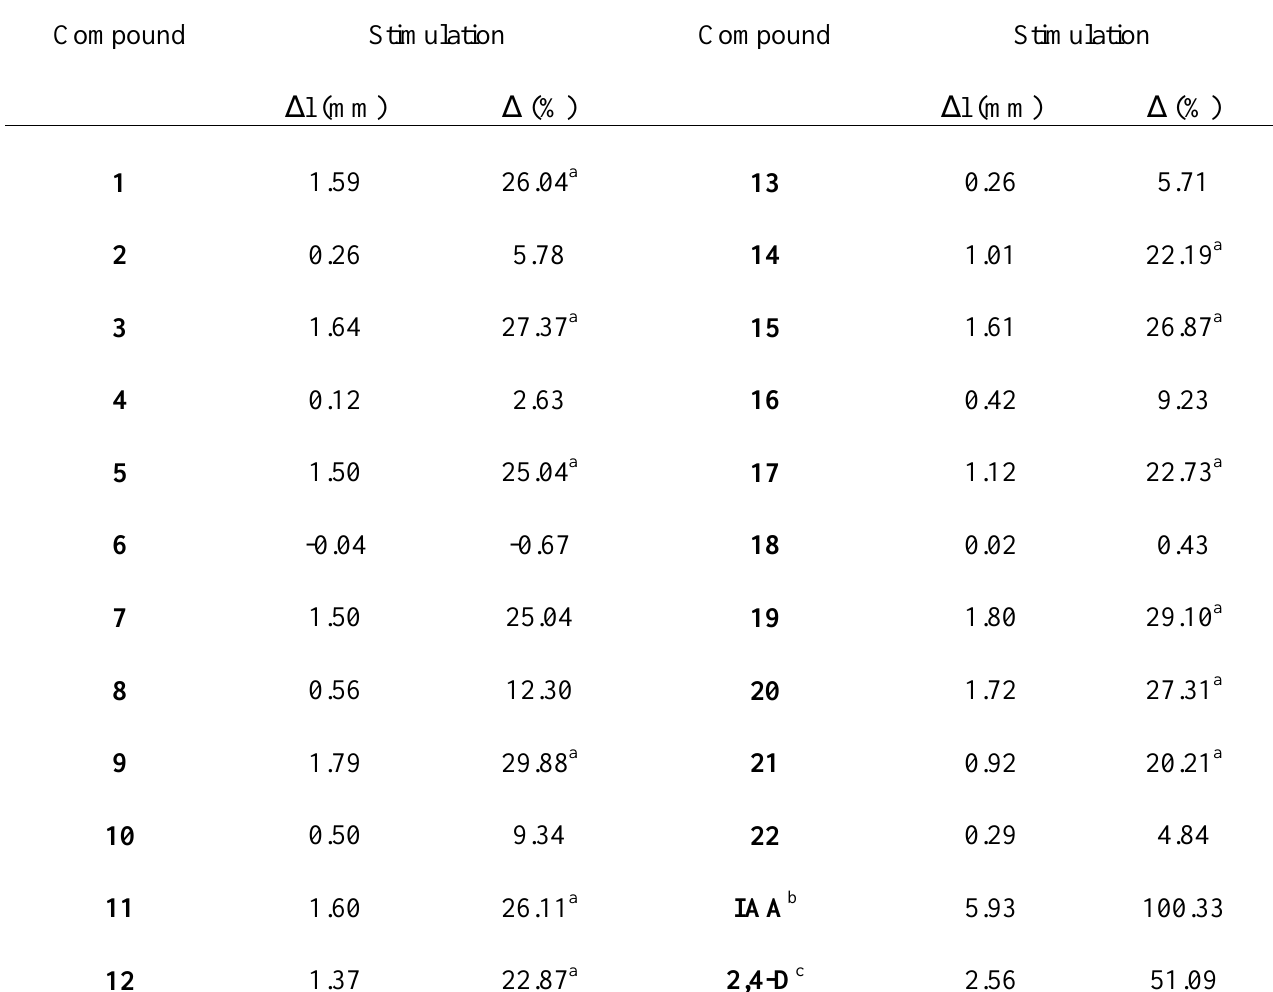
Table 1. Growth regulation activity of the synthesized compounds tested on Triticum aestivum L. (concentration of the compounds is 10 -5 mol dm -3